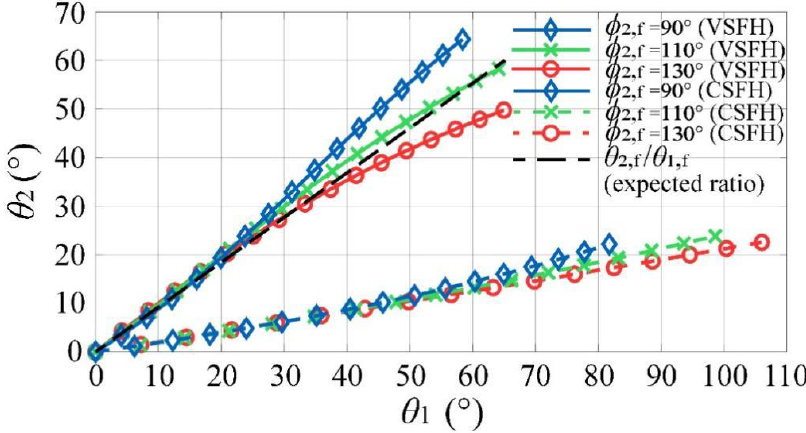
Figure 9. Results of flexion angles of VSFH and CSFH with different directions of the force ( F 0,max = 4 N) results of the stretching force of VSFH for stroke patients.